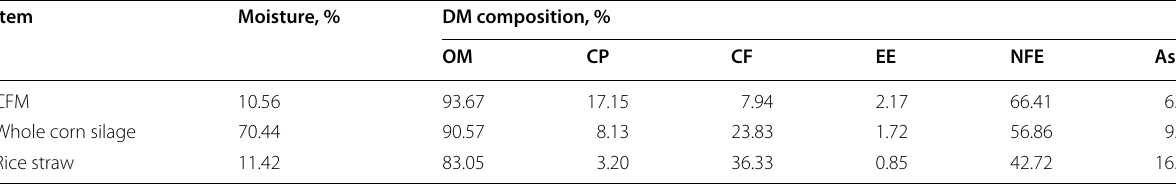
Table 1 Chemical composition of experimental feed‑stuffs as dry matter basis (DM)